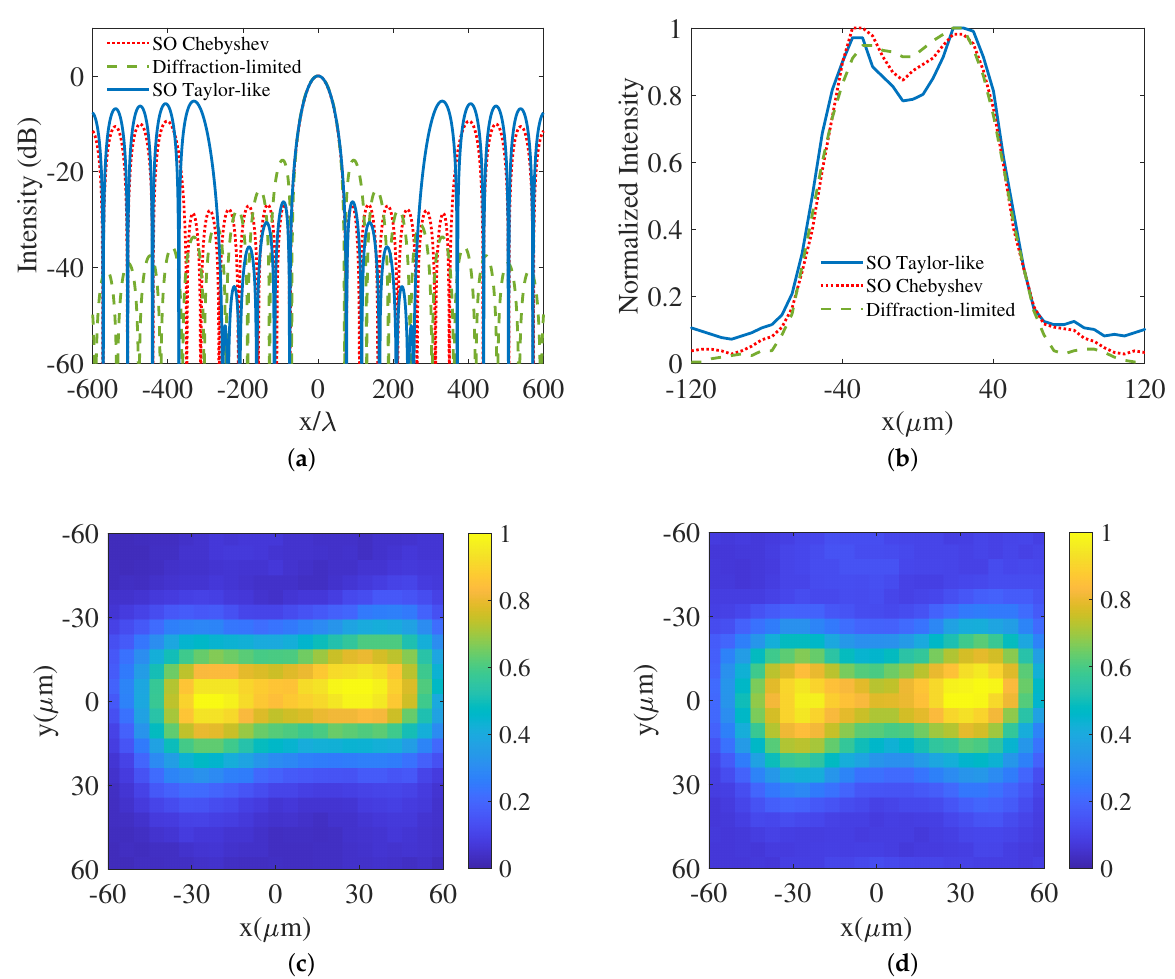
Figure 14. ( a ) Simulation results of super-oscillatory Chebyshev (red dotted line), super-oscillatory Taylor-like (blue line) and diffraction-limited (green dashed line) point-spread functions. (Note: the SO Chebyshev has slightly tapered sidelobes because the accuracy of the coefficients is limited by the bit-depth (8-bit in this SLM), and imperfect linearity of the applied voltage and modulated phase; ) ( b ) Intensity distributions along the x-axis in ( c ) (red dotted line) and ( d ) (blue line) compared with the diffraction-limited one (green dashed line). (Note: the equivalent Rayleigh criterion for a coherent optical system, which is the one used for this paper, is 0.82 λ / NA ≈ 60 µ m [11]). The experimental results of imaging two apertures ( c ) with super-oscillatory Chebyshev point-spread function; ( d ) with super-oscillatory Taylor-like point-spread function. (Note: to clarify the effect of the sidelobe structure on the resolution, the super-oscillatory point-spread functions are designed to have super-oscillatory sidelobes and the same beamwidth as the diffraction-limited one. Thus, the super-resolution would only result from the sidelobe